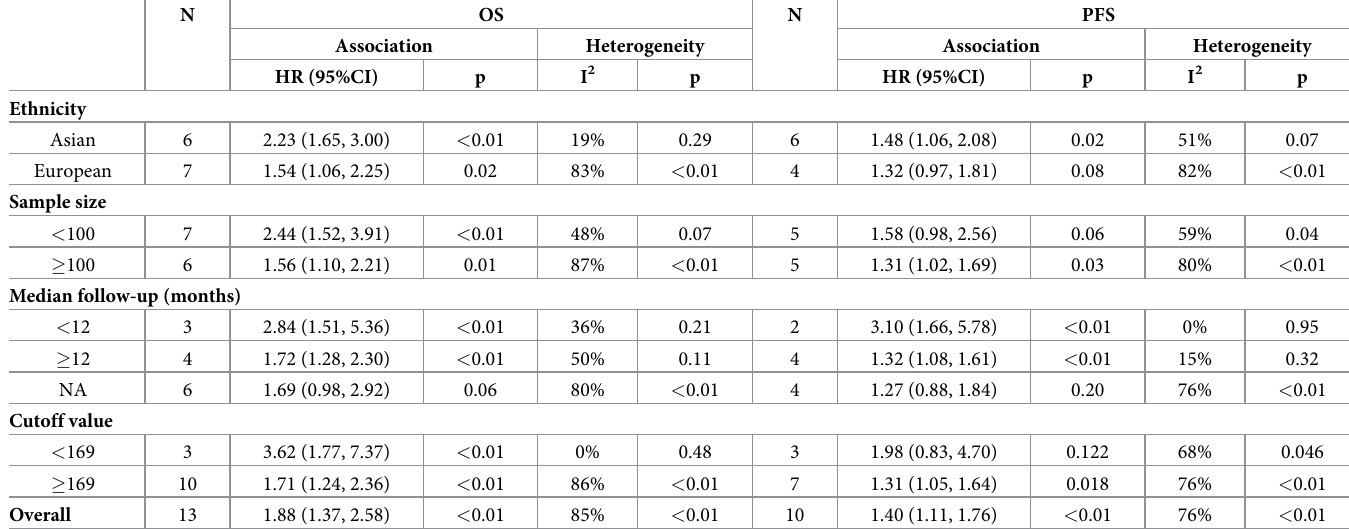
Table 2. Results of subgroup